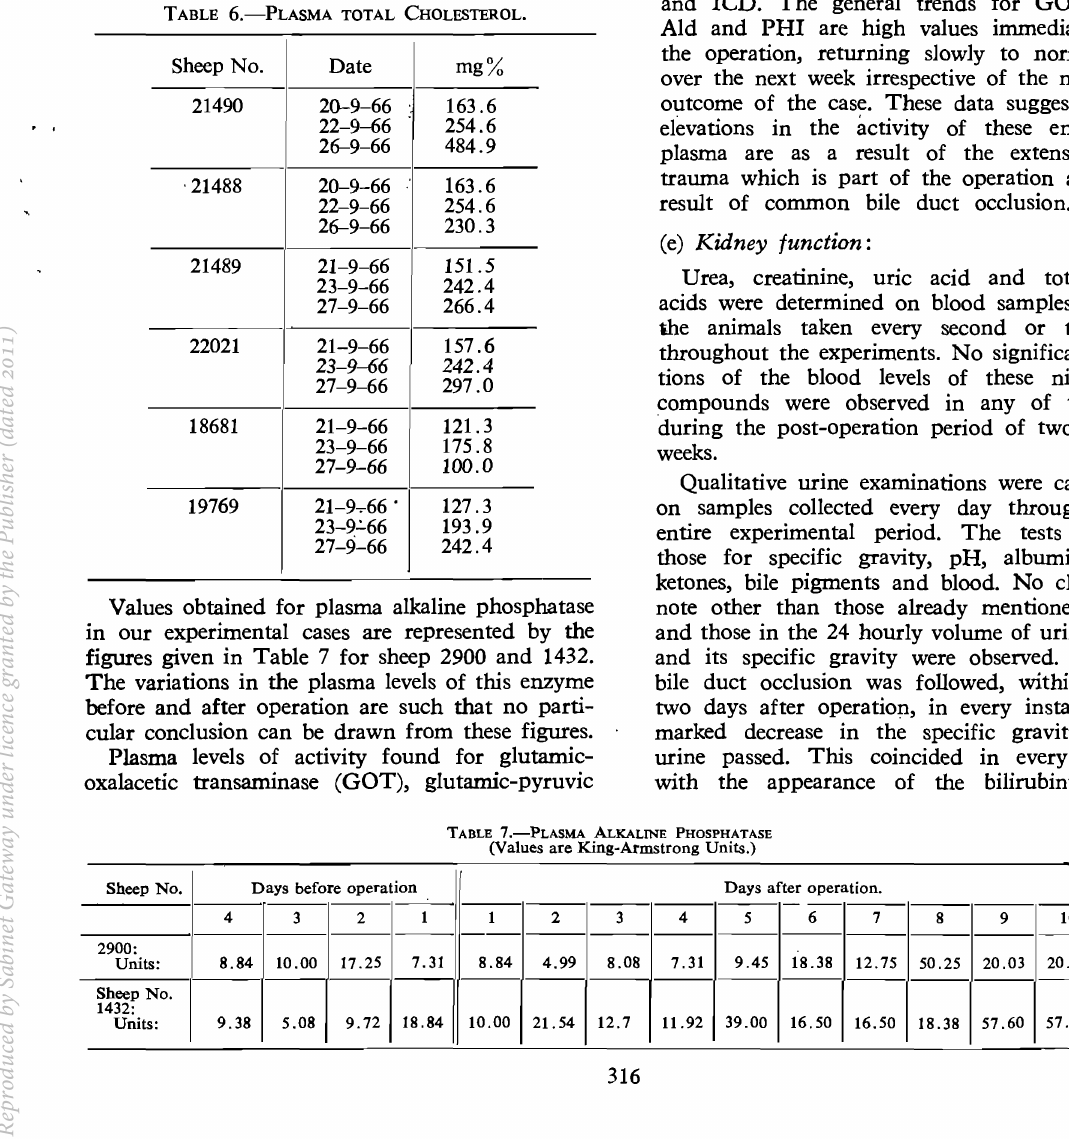
TABLE 6.-PLASMA TOTAL CHOLESTEROL. Sheep No.